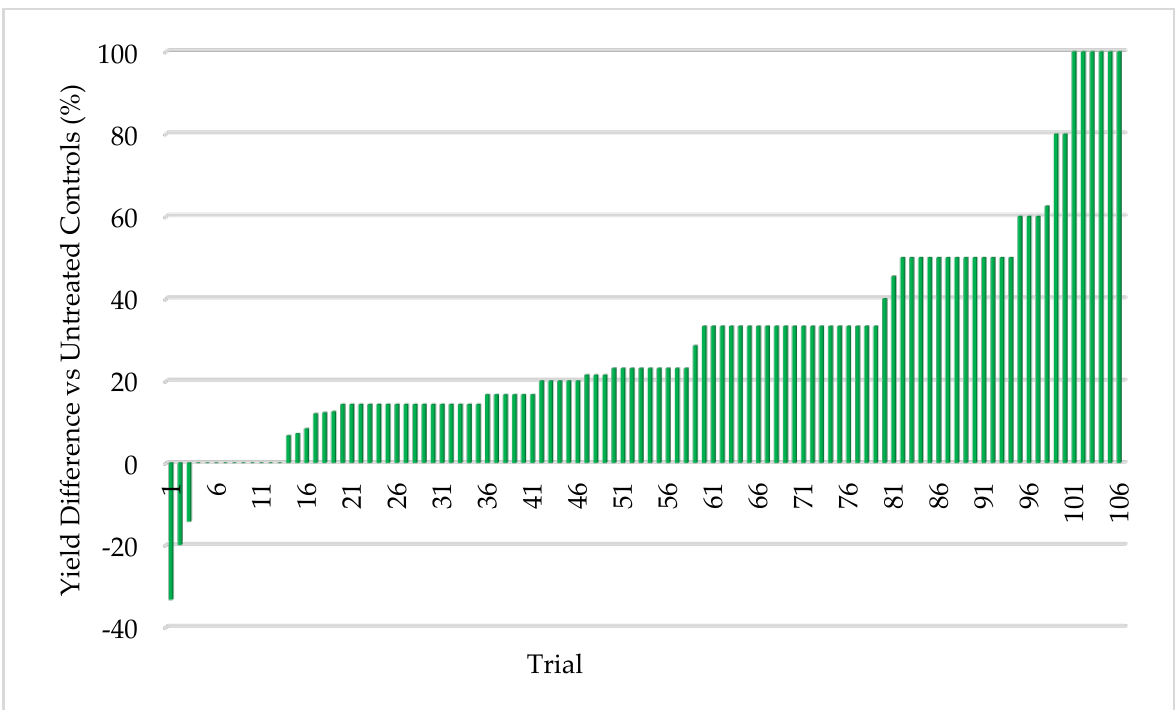
Figure 11. Pearl millet response to BioEnsure. 106 trials (0.1 – 5.0 acres/plot) were performed with carry-over and market seed. Each bar represents a separate comparative trial of treated (ThMS3a) vs untreated plant yields. Win rate was 96% with a minimum of 10% yield increase. Each test had a single replication of treated and untreated so it was not possible to include standard deviations or statistical analysis. Cooperators: farmers.